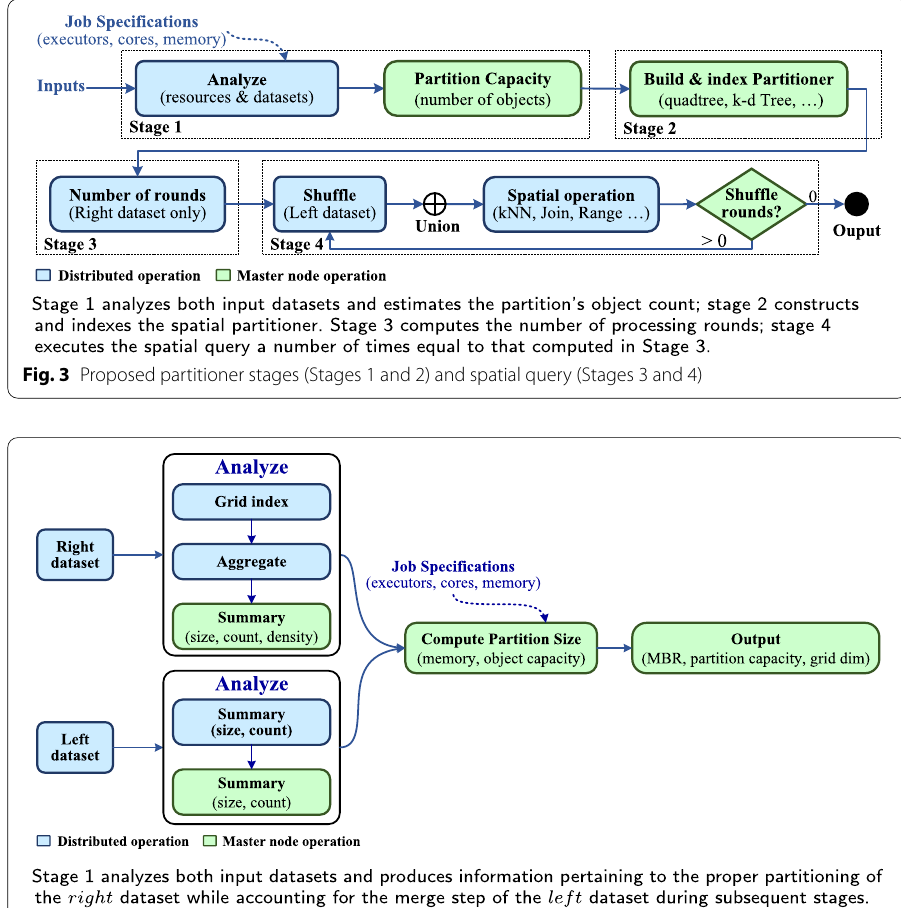
Fig. 4 Stage 1—analyzing the input